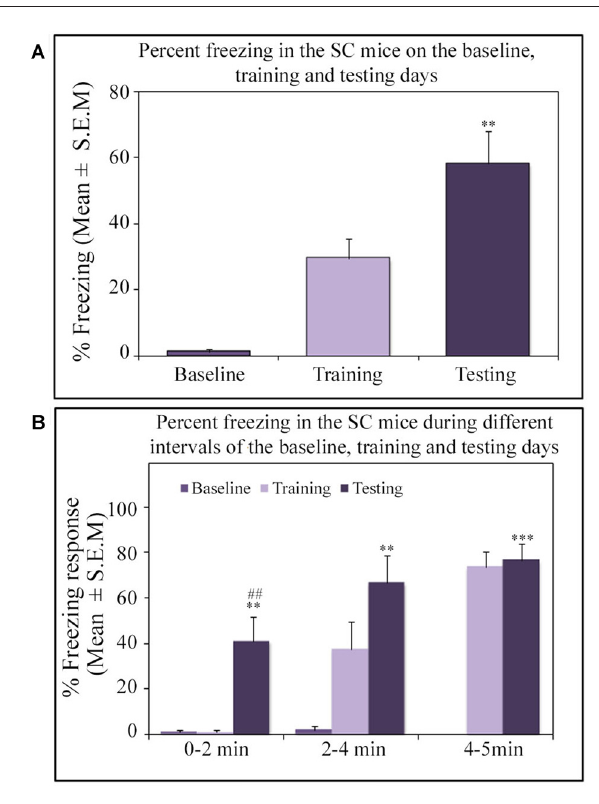
FIGURE 3 | The percent freezing response in the SC mice on the baseline, training and testing days. (A) The SC mice exhibited a significant increase in percent freezing ( p < 0.01, F ( 2,14 ) = 13.14) on the testing day (compared to baseline day: Tukey p < 0.01). (B) The percent freezing significantly increased on the testing day during the 0–2 min (compared to baseline day: Tukey p < 0.01; compared to training day: Tukey p < 0.01), 2–4 min (compared to